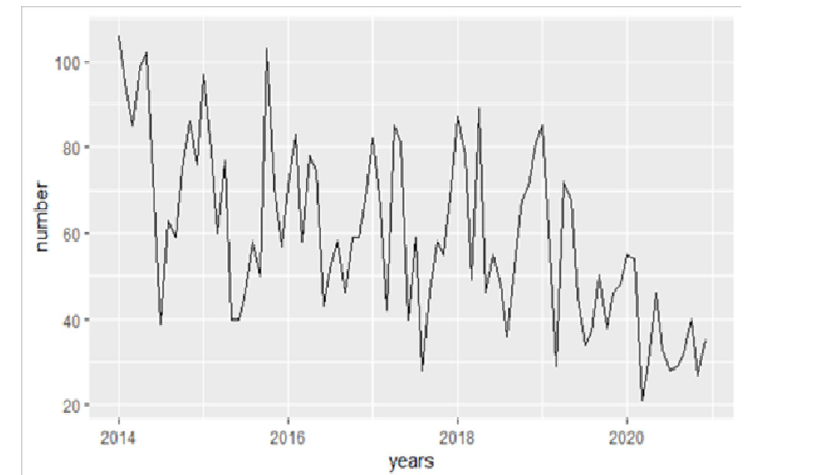
Fig 2. The trend of cutaneous CL in Kerman province, Iran during